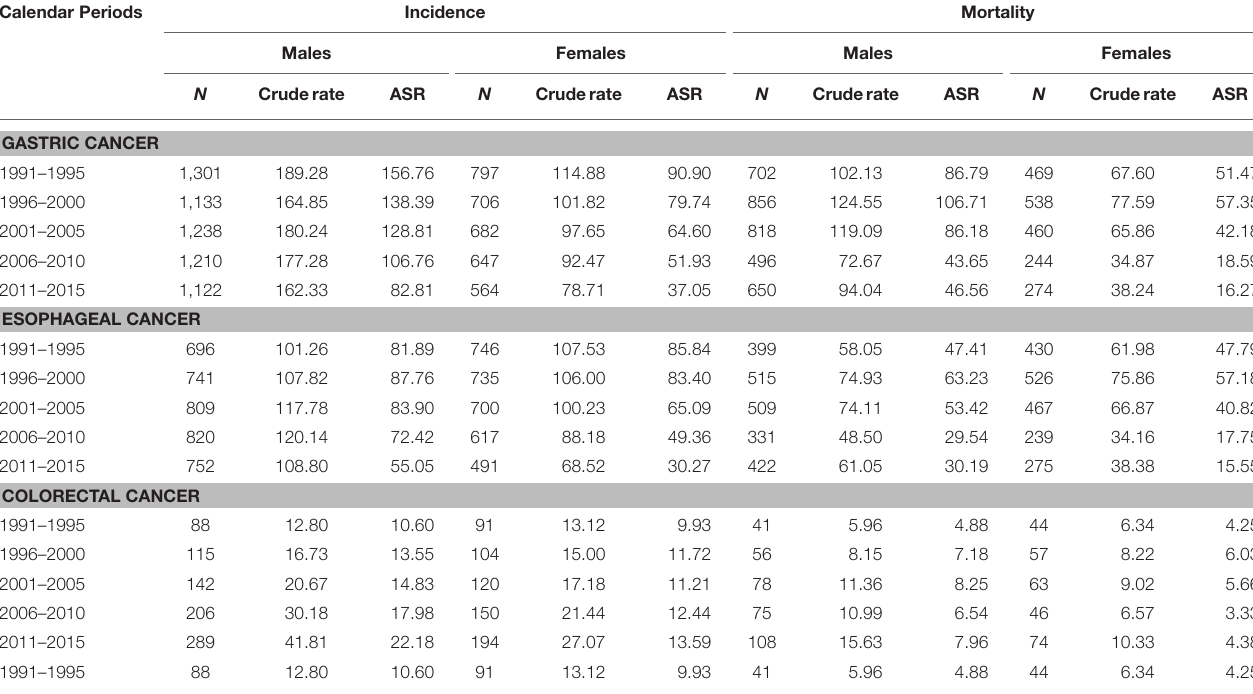
TABLE 1 | Crude and age-standardized incidence and mortality rates (ASRs) of gastrointestinal cancers per 1,00,000 person-years in Yangzhong and calendar periods during 1991–2015. Calendar